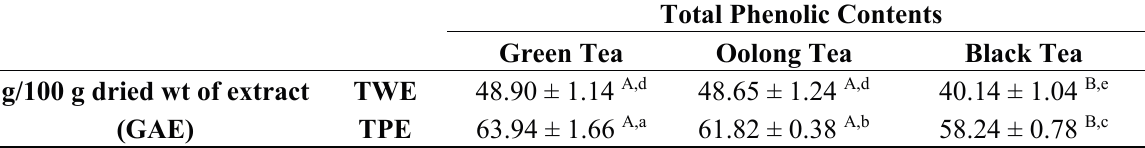
of green, oolong, and black